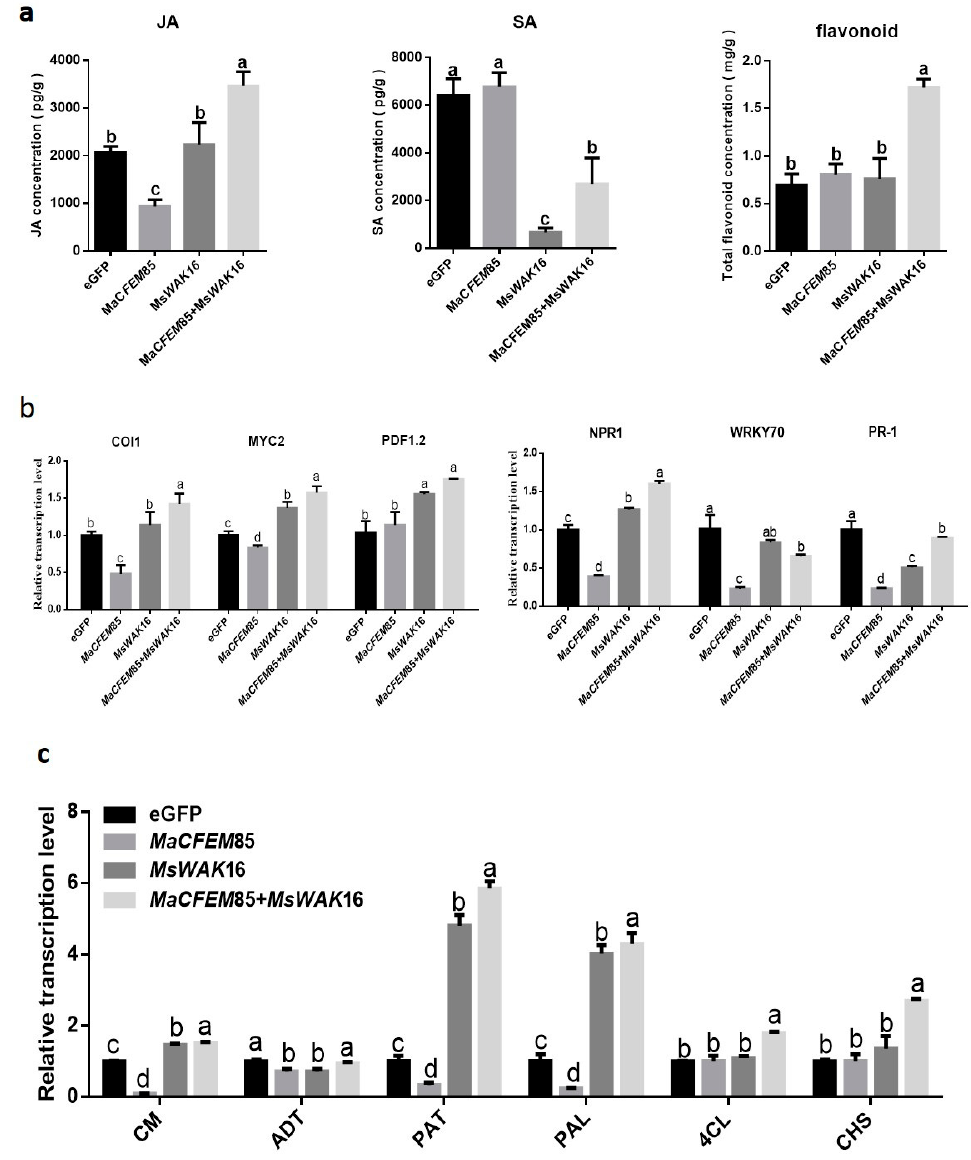
Figure 5. Hormone levels and hormone response gene expression. ( a ) Levels of jasmonic acid (JA), salicylic acid (SA), and total flavonoids in N. benthamiana after transient expression of eGFP, MaCFEM85, MsWAK16, or MaCFEM85+MsWAK16 for 12 h. ( b , c ) Genes related to plant defense responses were measured in N. benthamiana leaves at 12 h after infiltration with Agrobacterium containing plasmids encoding eGFP, MaCFEM85, MsWAK16, or MaCFEM85+MsWAK16. Data are presented as the mean ± standard deviation from three biological replicates. Letters indicate statistical significance between groups at p < 0.05. Abbreviations: Chorismate mutase, CM; Prephenate dehydratase, ADT; Aspartate-prephenate aminotransferase, PAT; phenylalanineammonialyase, PAL; 4-coumarate coenzyme A ligase, 4CL; Chalcone synthase, CHS.